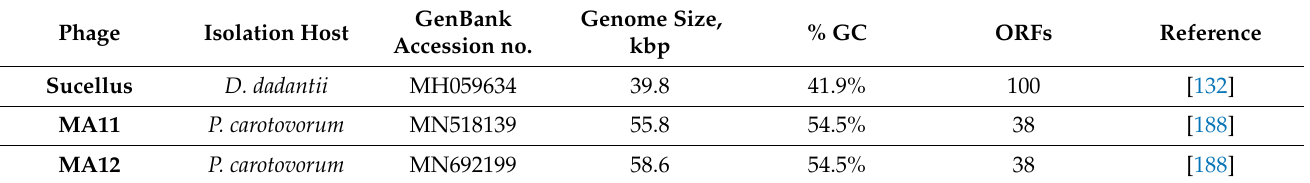
Table 6. Genomic properties of Siphoviridae bacteriophages infecting